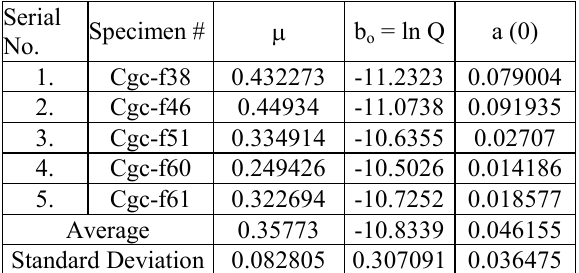
Table 4. Fatigue crack growth parameters for